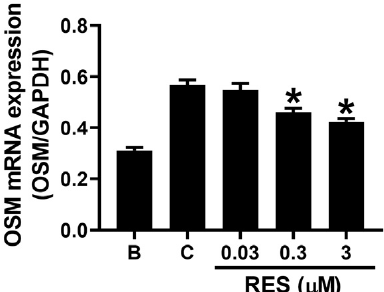
Figure 3. Effects of RES on the mRNA expression of OSM in neutrophil-like dHL-60 cells. dHL-60 cells (1 × 10 6 ) were exposed to RES (0.03 to 3 µM) for 1 h, and then stimulated with GM-CSF (5 ng/mL) for 1 h. B, PBS-treated and unstimulated cells; C, PBS-treated and GM-CSF-stimulated cells. B, PBS-added and unstimulated cells; C, PBS-added and GM-CSF-stimulated cells. Data are shown as the mean ± SEM of three independent experiments. * p < 0.05 vs. the PBS-added and GM-CSF-stimulated cells.